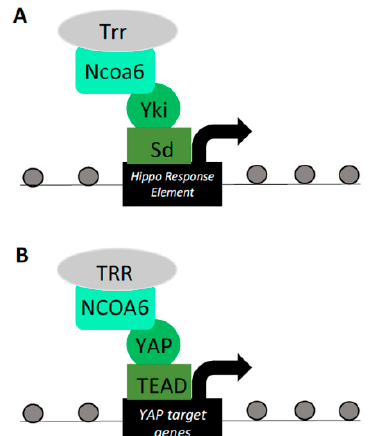
Figure 4. Yorkie / YAP interactions with the histone methyltransferase (HMT) complex. ( A ) Ncoa6, a component of the Trithorax-related (Trr) H3K4 methyltransferase complex, binds to Yki–Sd and is capable of activating a Hippo response element (HRE) reporter in Drosophila . Ncoa6 interaction with Yki–Sd drives the expression of Yki target genes, inducing tissue growth and H3K4 methylation at these loci. ( B ) Human NCOA6 interaction with YAP–TEAD drives the expression of YAP target genes, providing evidence for evolutionary conservation between this Yki/YAP–HMT interaction.